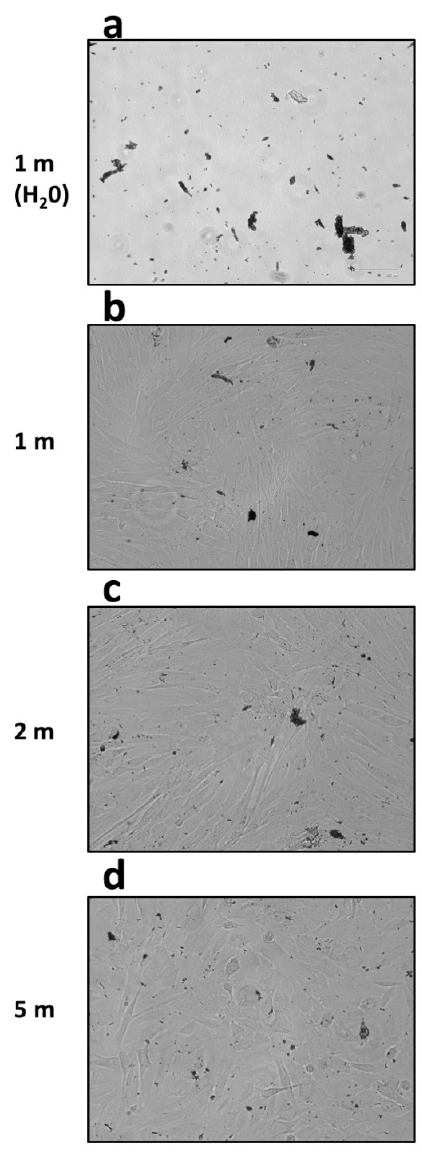
Figure 2. Presence of abundant and heterogenous debris observed at inverted light microscopy in samples processed with Rigenera ® (EVOS FLoid Cell Imaging Station, ×460 optical magnification). ( a ) The cell-free control sample, which consisted of UltraPure™ distilled water (10977023, Invitrogen) alone processed for 1 min. Fibroblast samples were processed instead for 1, 2, or 5 min (( b – d ) respectively).